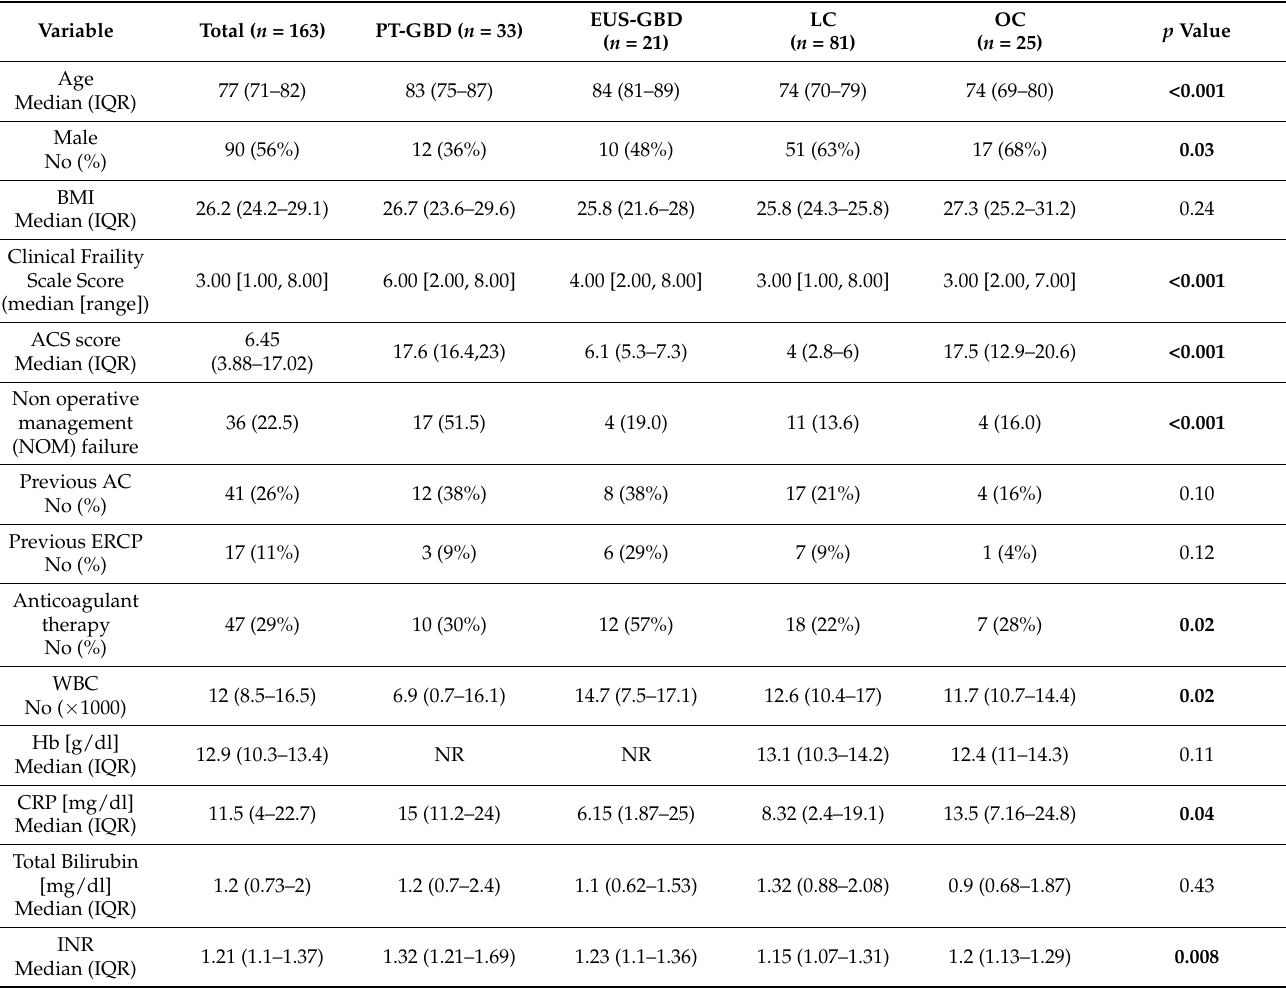
Table 1. Baseline patients’